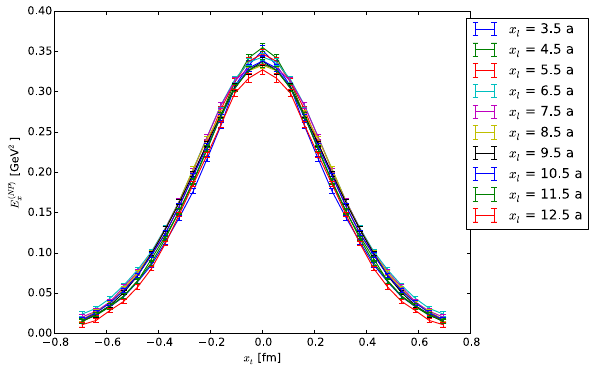
Fig. 5 Transverse cross sections of the non-perturbative field E NP x ( x t ) at β = 6 . 370, d = 0 . 85 fm, for several values of x l